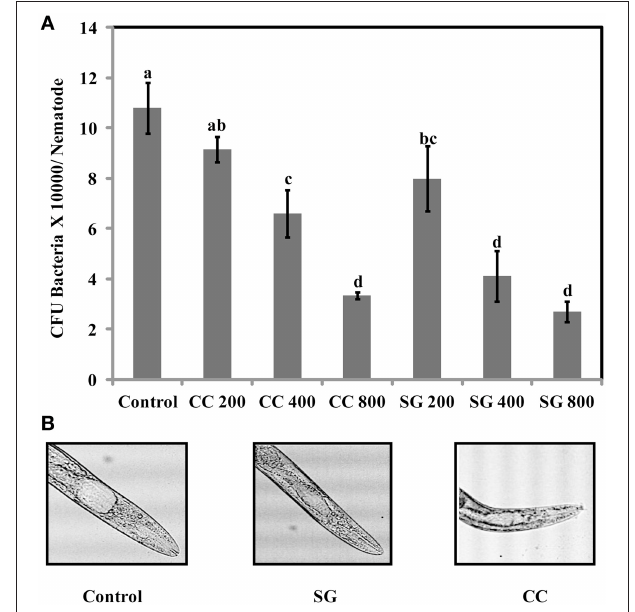
FIGURE 8 | S. Enteritidis colony counts in the gut of C. elegans . (A) Effect of SWE on bacterial CFU count in the C. elegans gut. (B) Microscopic images showing the gut of C. elegans infected with S. enteritidis. In control the gut is swelled while much less swelling was observed when infected nematodes were treated with SWE. Values with different superscript letters are significantly different (Tukey multiple mean comparison, p < 0.05). Values represent Mean ± Standard deviation from two experiments with six biological